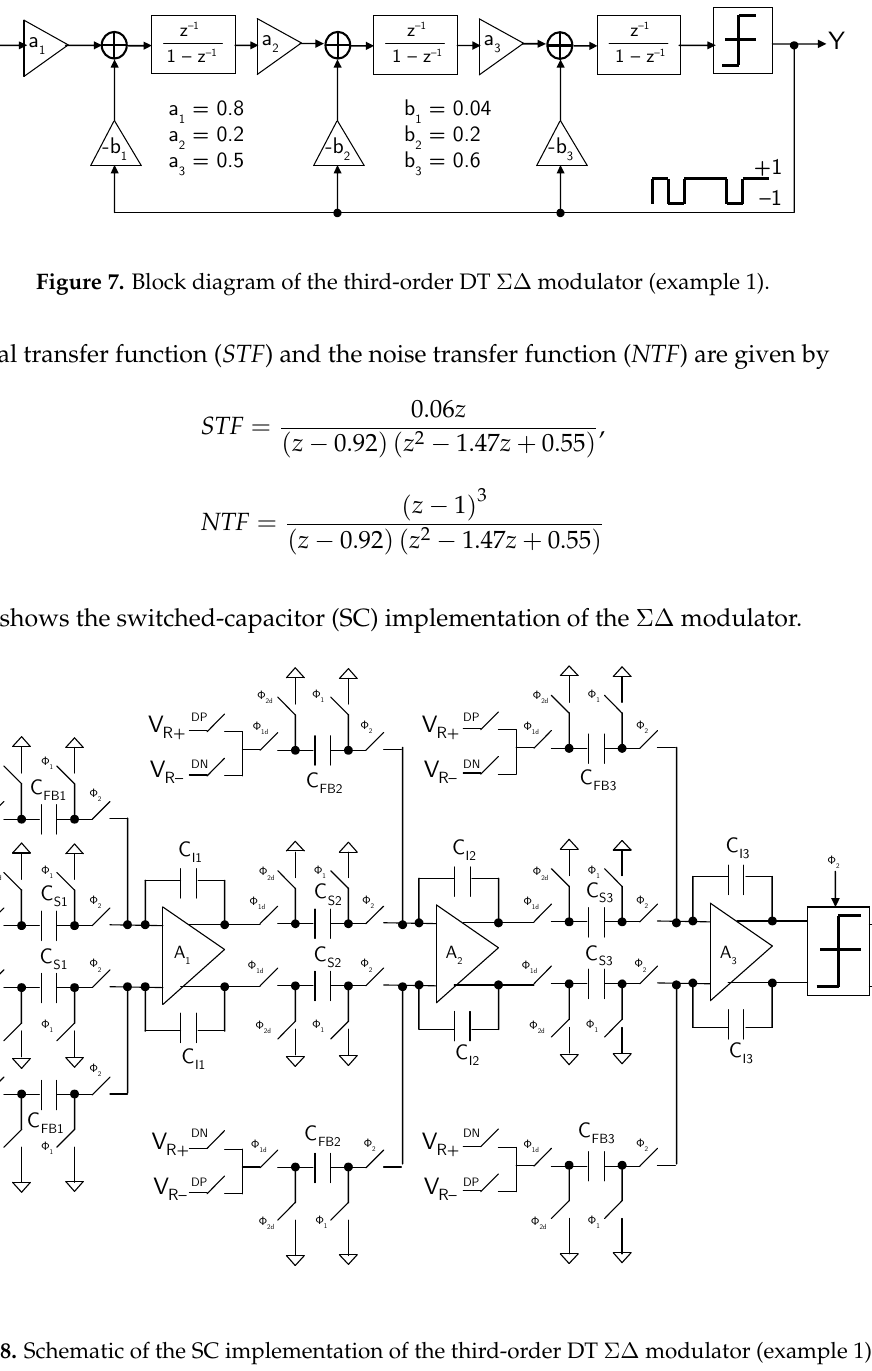
Figure 8. Schematic of the SC implementation of the third-order DT ΣΔ modulator (example